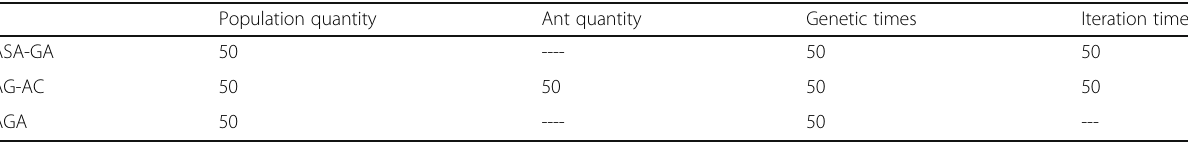
Table 1 Algorithm parameter